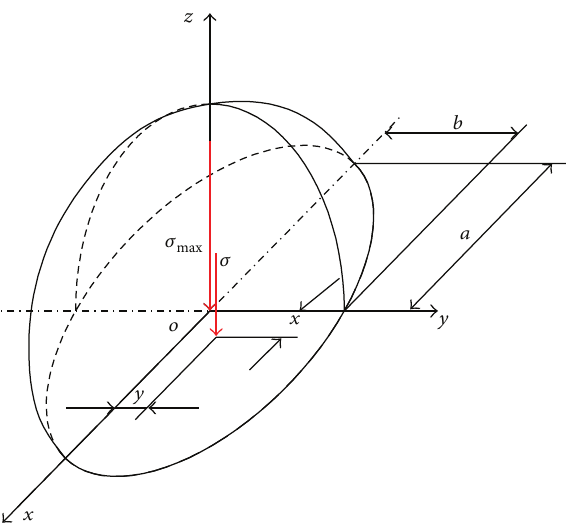
Figure4:Ellipsoidalsurfacecompressivestressdistributionofpoint